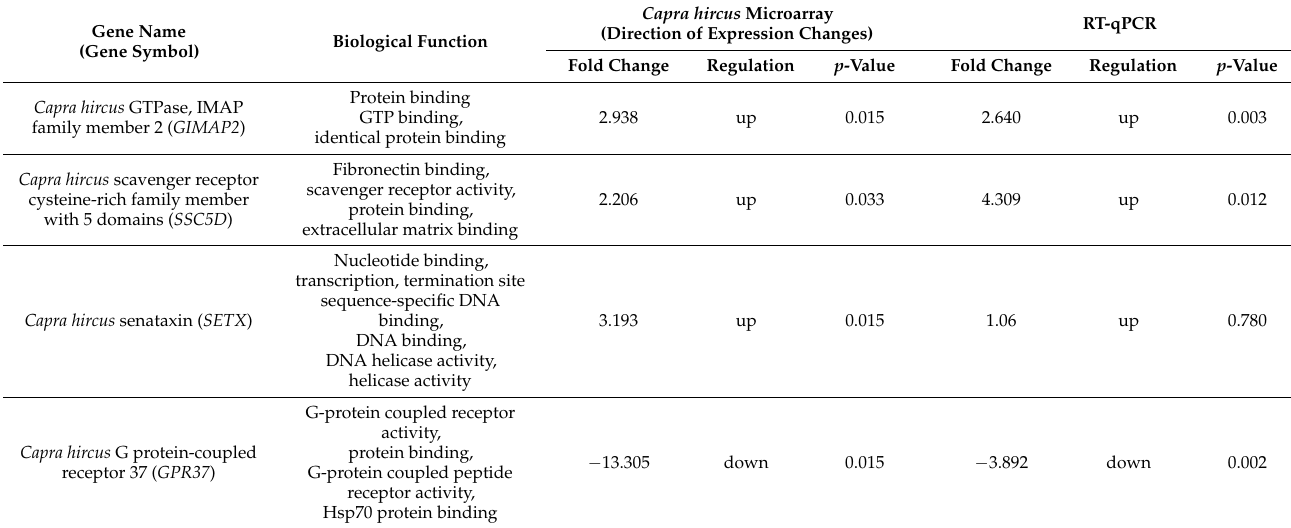
Table 2. Differentially expressed genes in the PBNCs of dairy goats at the peak of the first lactation ( n = 8): a comparison between SRLV-SP and SRLV-SN goats.